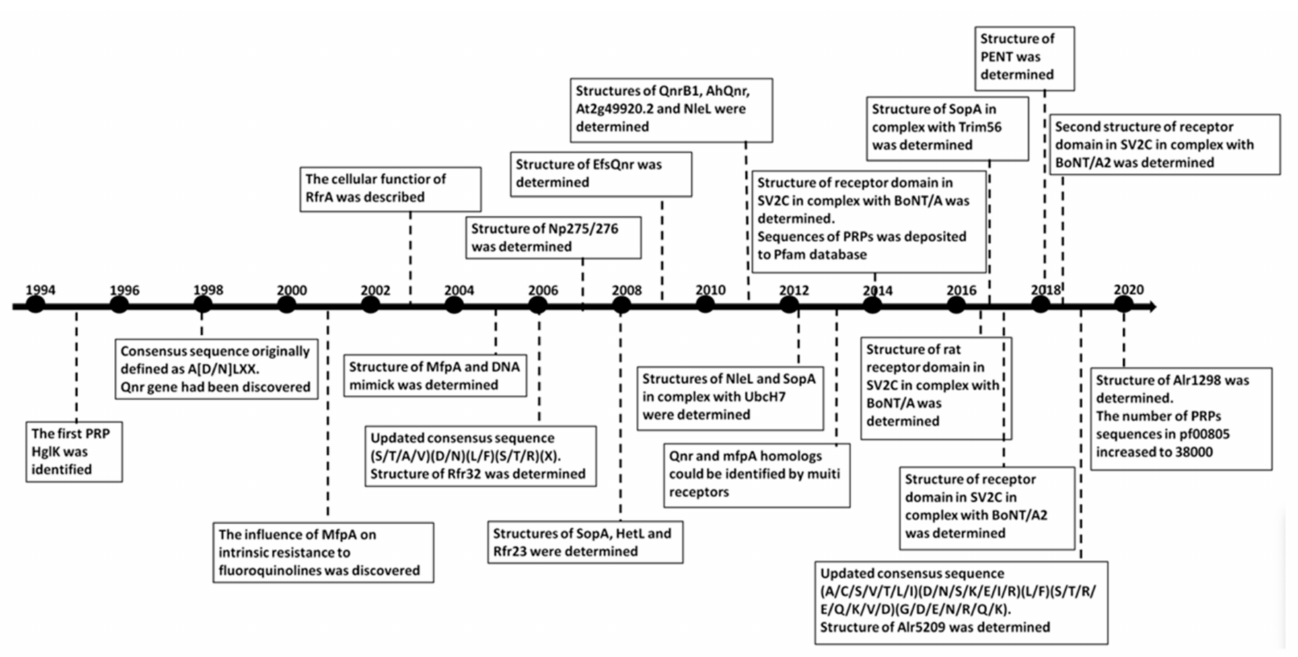
Figure 1. Milestones in the timeline investigation of the structure and function of